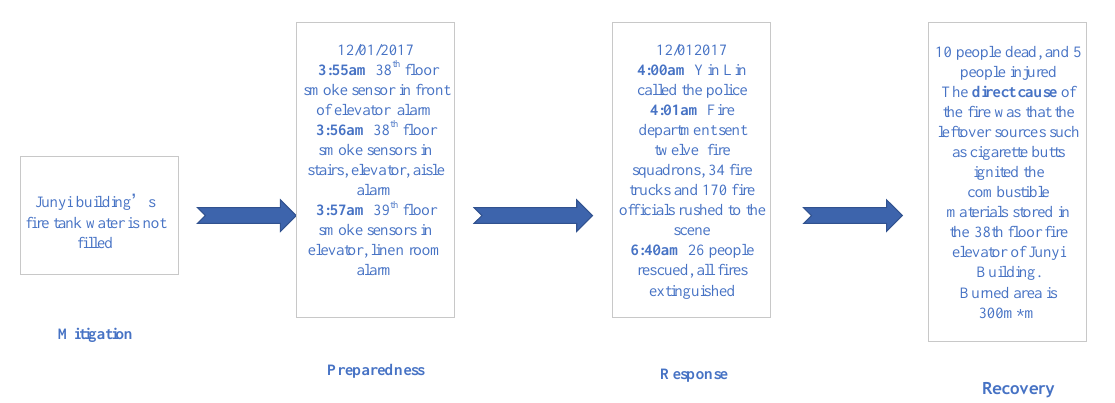
Figure 5. Detail information of Tianjin “12.1” major fire